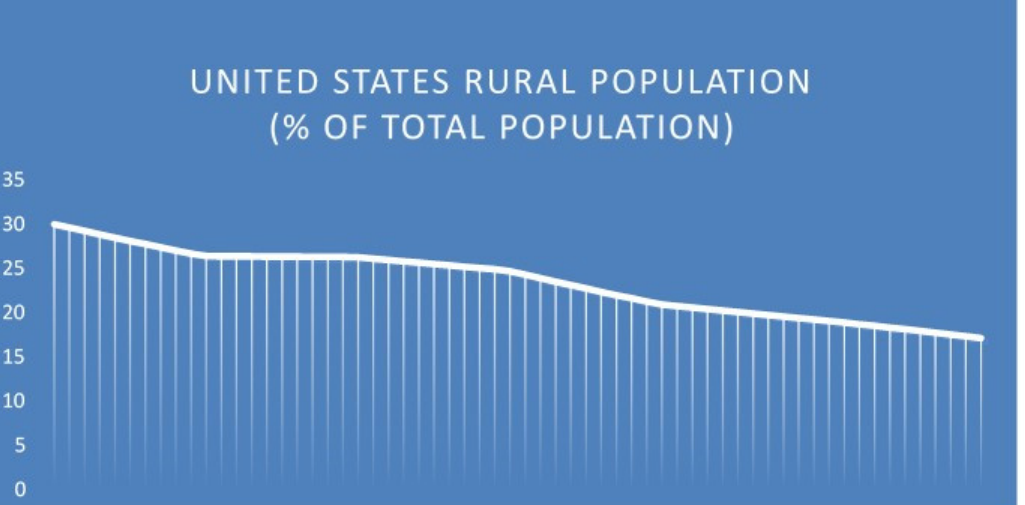
Figure 1. World Bank Rural Population Estimates (1960–2021). Rural population refers to people living in rural areas as defined by the national statistics office. It is calculated as the difference between the total population and the urban population. Source: World Bank.